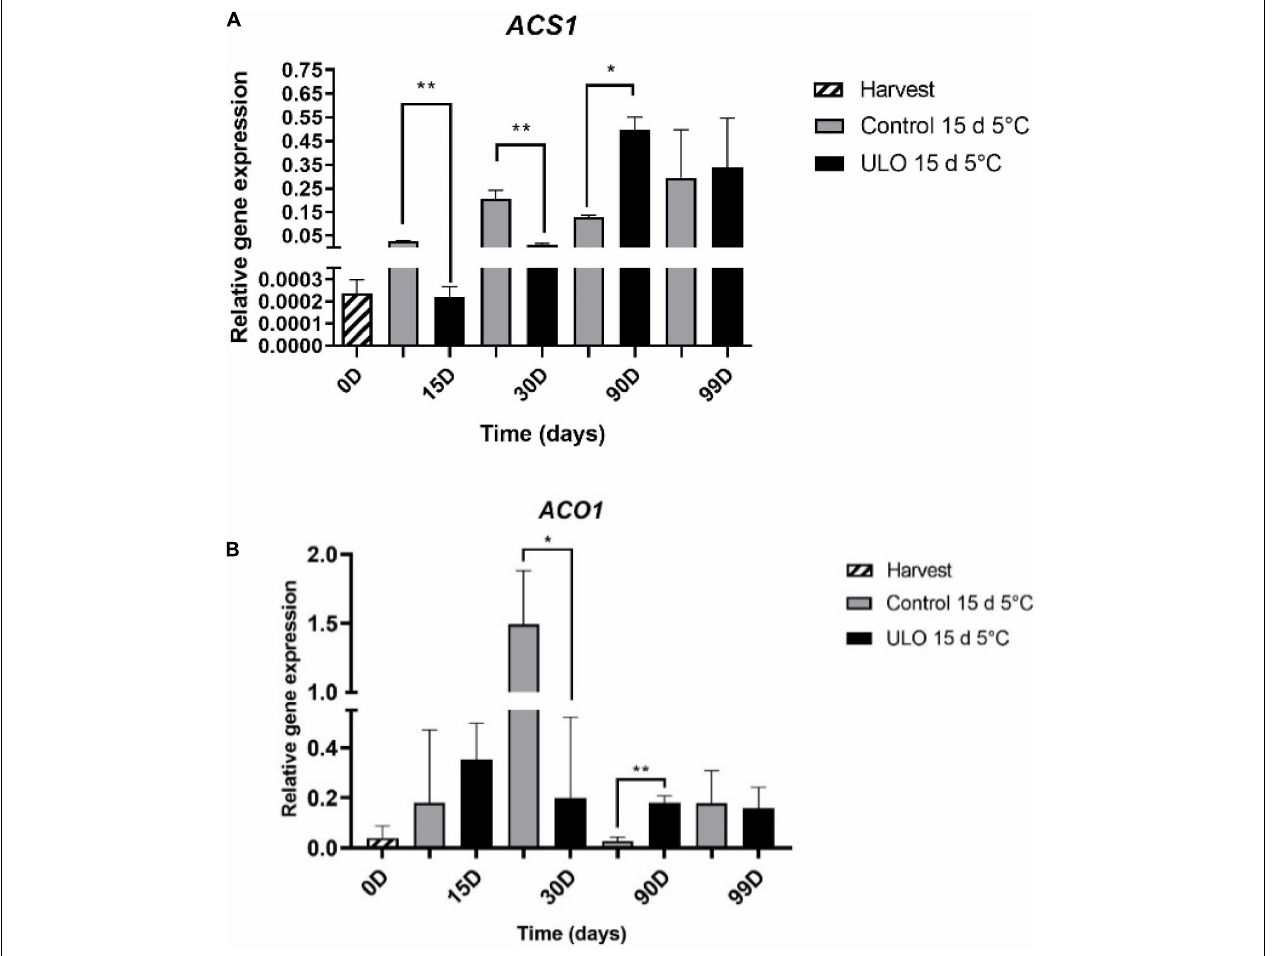
FIGURE 6 | Relative expression of genes involved in ethylene synthesis pathway: MdACS1 (A) and MdACO1 (B) . Data were obtained in cortical tissues of ‘Fuji’ apple fruit from ULO and control at harvest, 15 and 30 days of conditioning at 5 ◦ C, 90 days of storage at 0 ◦ C, and 9 days of ripening at 20 ◦ C. Expression level was measured relative to that of MdGAPDH . Bars indicate standard error significantly different according to Tukey’s test * P < 0.05, ** P <